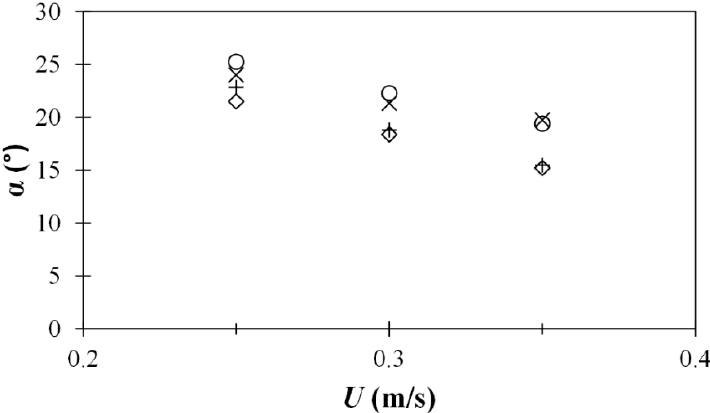
Figure 6. The wake angles versus velocity U under different penetration depths (f1r4, f1r3, f1r2 and f1r1 represent penetration depths of 1/30, 1/6, 1/2 and 1/1 of the water, respectively).